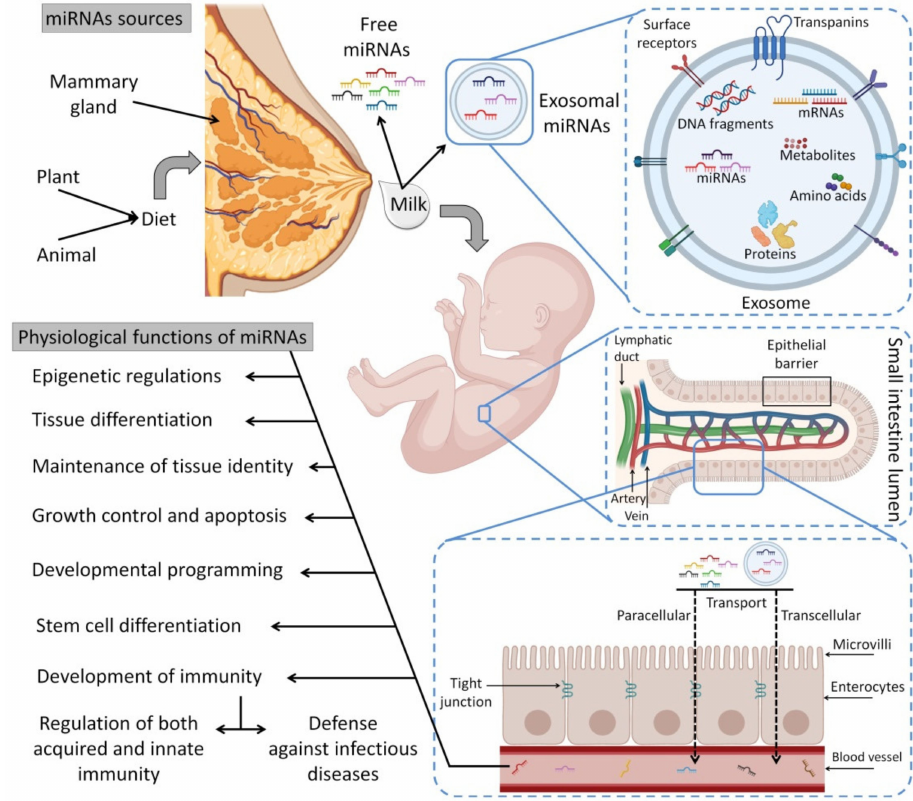
Figure 5. HBM-derived miRNAs and their physiological functions in breastfed infants. Compared to other human biofluids, HBM is an abundant source of miRNAs that present as free molecules or packaged into a type of extracellular vesicle called exosomes. Although the majority of these miRNAs originate from the mammary epithelium, there is a small contribution from the miRNAs that transport from the maternal circulation. Evidence indicates that diet-derived miRNAs from plant and animal sources are presented in human circulation and thus can be transported to HBM. In the infant’s GIT, HBM-derived miRNAs cross intestinal epithelial cells to blood circulation and reach various human organs and tissues. Interactions of miRNAs with their complementary regions within targeted mRNAs affect gene expression and ultimately result in regulating essential physiological functions required for infant growth and development [199,205–207]. Created with BioRender.com, accessed on 22 April